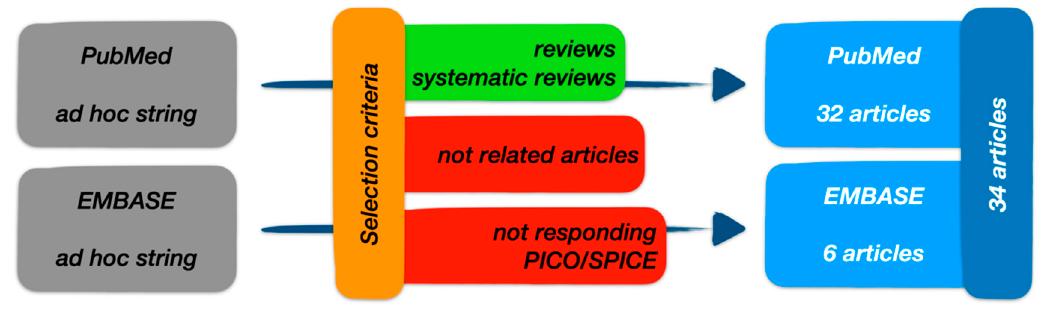
Figure 5. Research strategy flow-chart.